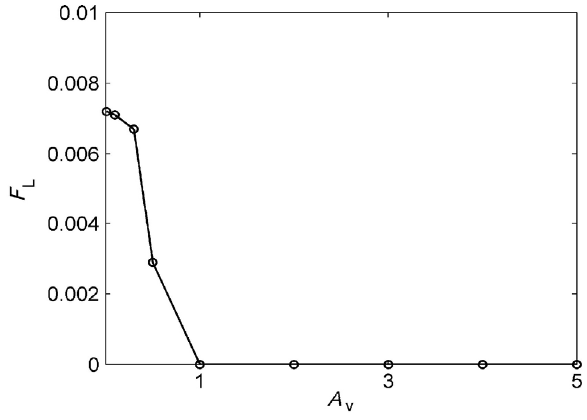
Fig. 3 Dependence of average friction force on repulsion intensity.